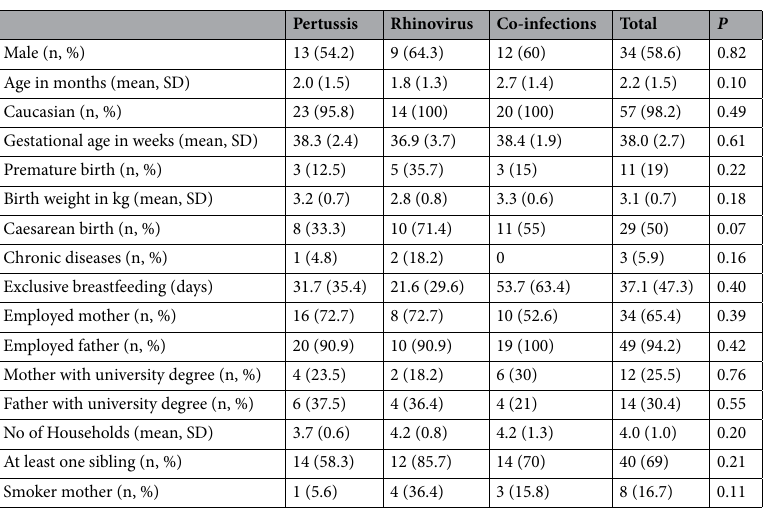
Table 1. Socio-demographic characteristics of patients enrolled by type of infection. Data are reported as number and percentage, or as mean value and standard deviation (SD) reported in round brackets. Statistical significance was evaluated by Chi-square test or Fisher’s exact test for proportions and Kruskal–Wallis test for